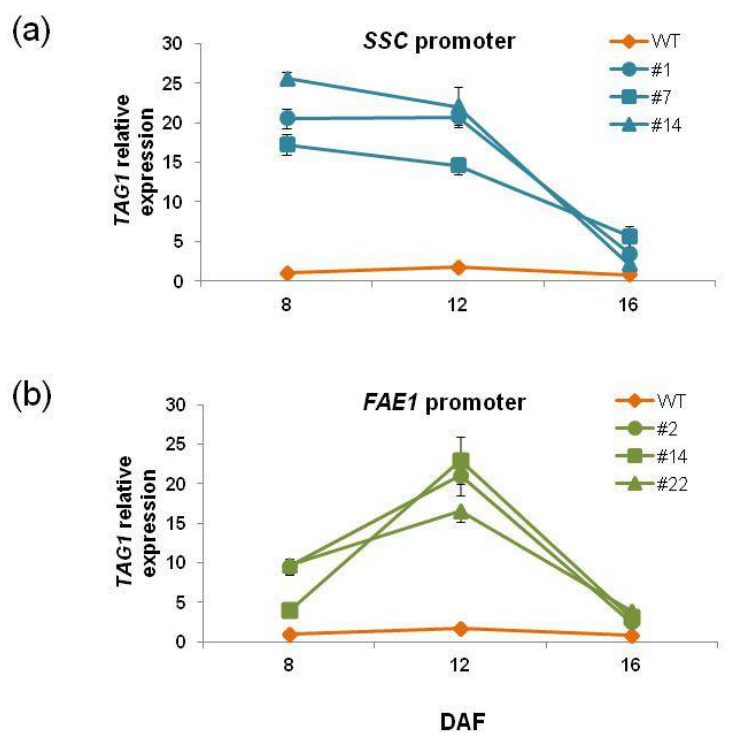
Figure 7. TAG1 expression in seeds from transgenic plants. The expression levels of TAG1 in seeds at 8, 12 and 16 days after flowering (DAF) in ( a ) SSCpro:TAG1 and ( b ) FAE1pro:TAG1 seeds were quantified by quantitative reverse transcription–polymerase chain reaction (qRT–PCR) and presented as relative values versus the level in WT seeds at 8 DAF. The gene expression levels were normalized using ELONGATION FACTOR1 α A4 ( EF1 α A4 ). Data shown represent the mean ± standard deviation of 3 (seeds at 8 DAF) and 5 (seeds at 12 and 16 DAF) biological